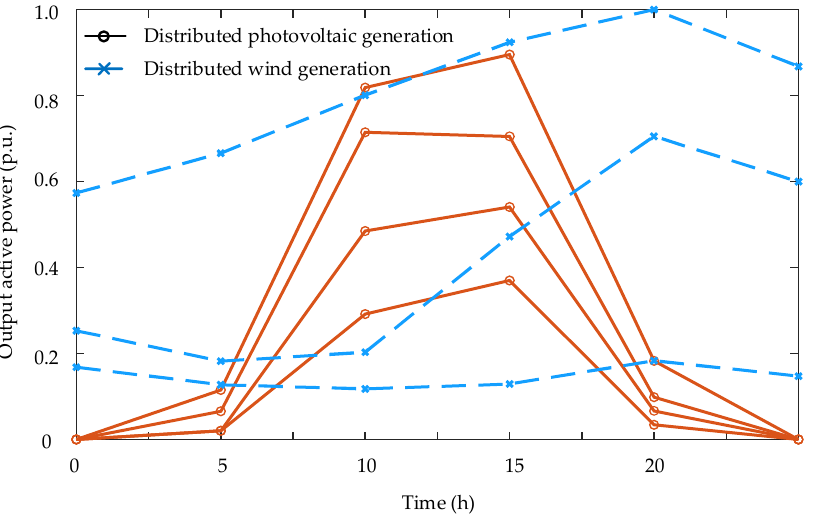
Figure 2. The topology of an actual 20 kV distribution network. The evaluation model takes the actual distributed photovoltaic generation, distrib- uted wind generation output and load curves of the region into consideration. Based on three distributed wind generation output curves and four distributed photovoltaic gener- ation output curves, 12 daily operation scenarios are formed. Each daily operation sce- nario includes six scheduling periods. The output curves after standardization are shown in Figure 3.